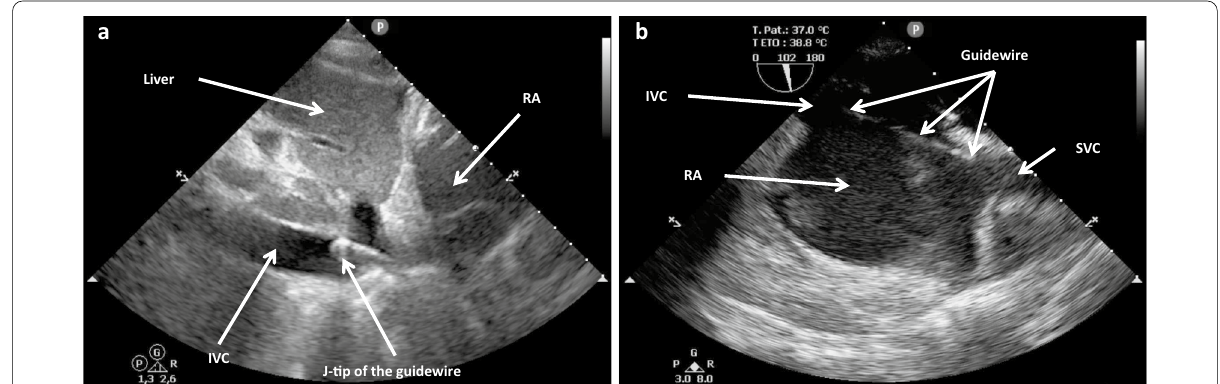
Fig. 4 a Transthoracic echocardiography subcostal view showing the J-tip of the guidewire entering the inferior vena cava. b Transesophageal echocardiography bicaval view showing the guidewire passing through from the superior vena cava into the right atrium and entering into the inferior vena cava. RA right atrium, SVC superior vena cava, IVC inferior vena